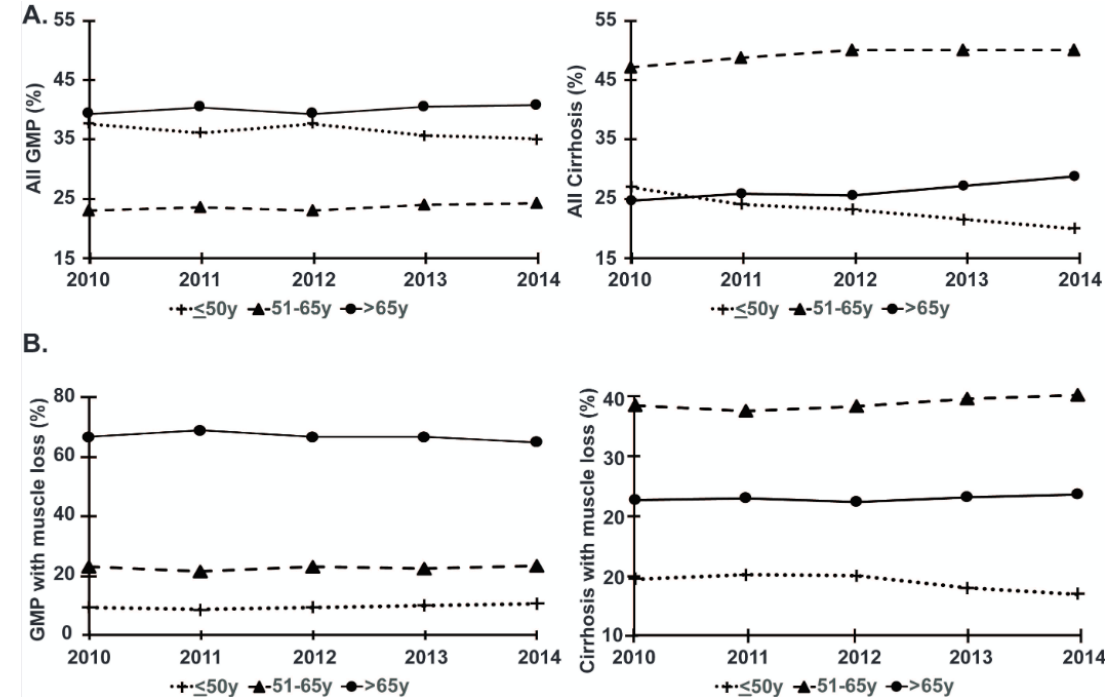
Figure 1. Increasing proportion of older patients with cirrhosis with and without muscle loss phenotype. ( A ) Line graphs depicting percentage of the analyzed random 2% inpatient sample of the general medical population (GMP) and hospitalized patients with cirrhosis from the National Inpatient Sample (NIS) database each year from 2010–2014 who were ≤ 50, 50–64, and >65 years old. ( B ) Line graphs depicting percentage of the analyzed inpatient sample of those GMP or patients with cirrhosis with muscle loss phenotype each year from the NIS from 2010–2014 who were ≤ 50, 50–64, and >65 years old.